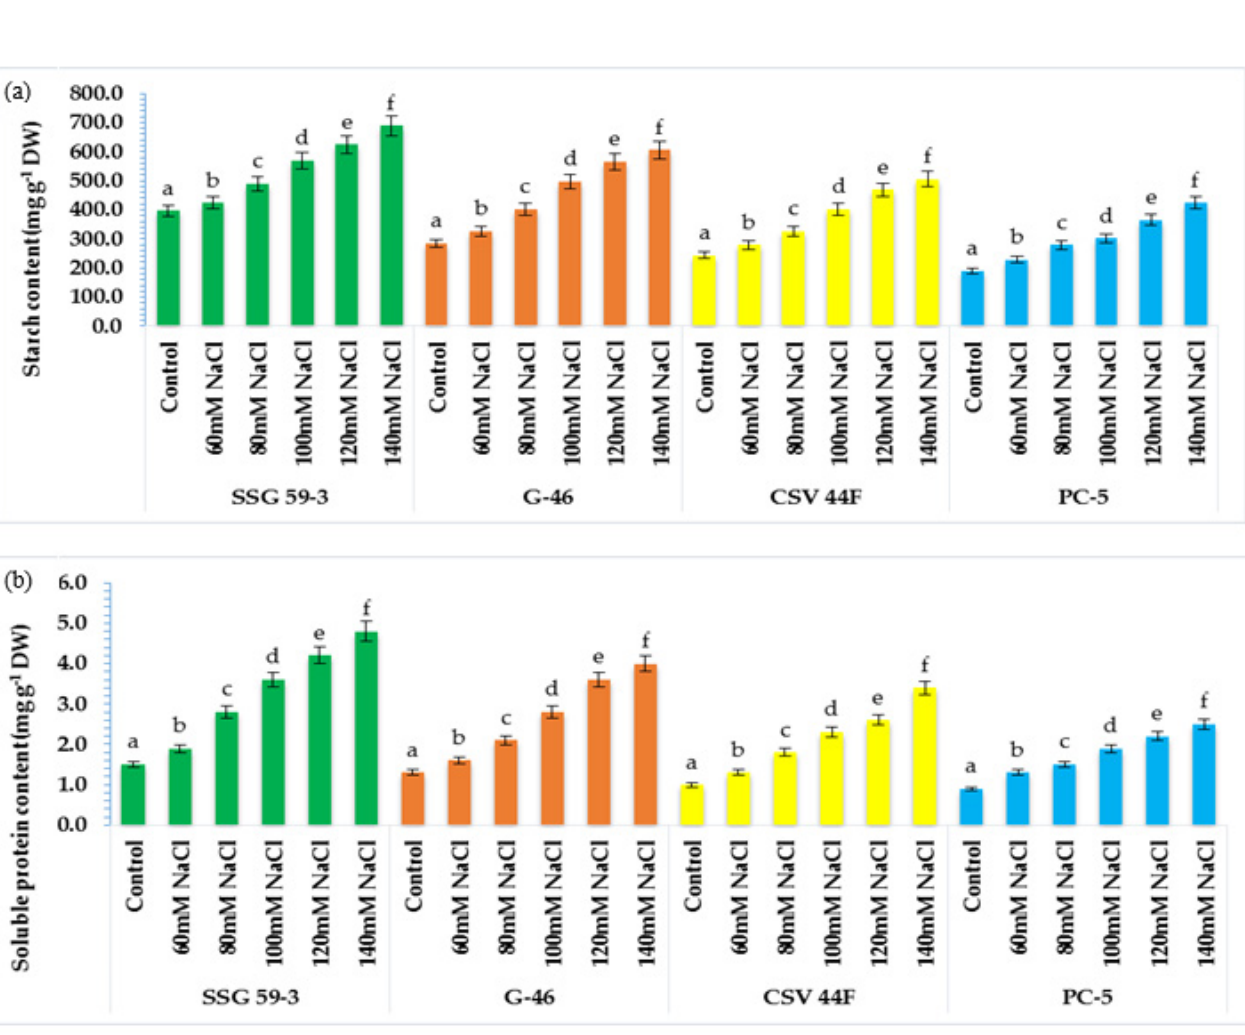
Figure 5. Effect of salinity on ( a ) starch and ( b ) protein content in germinating seeds of sorghum. Each value is the mean of triplicate. a–f Values with different superscripts in the same row are significantly different at p < 0.05.